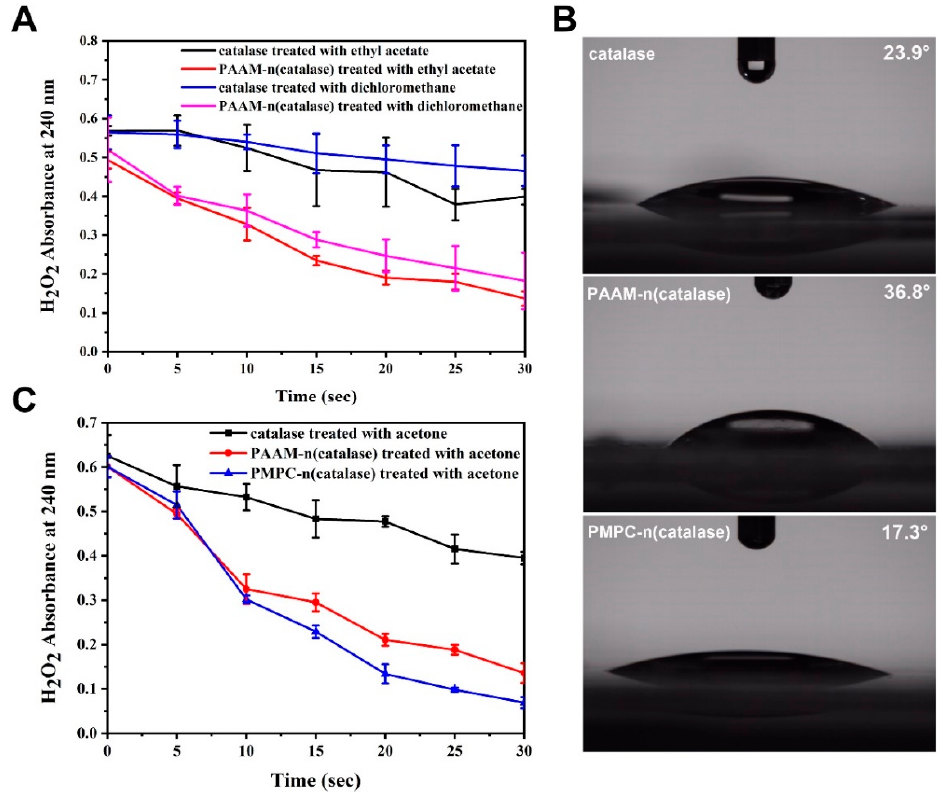
Figure 4. ( A ) Native catalase and PAAM-n(catalase) were treated with organic solvents and their activities were tested by the degradation kinetics of H 2 O 2 ; ( B ) native catalase, PAAM-n(catalase), and PMPC-n(catalase) were pressed as films and their contact angles were tested; the magnification was 5 times; ( C ) native catalase, PAAM-n(catalase), and PMPC-n(catalase) were treated with acetone